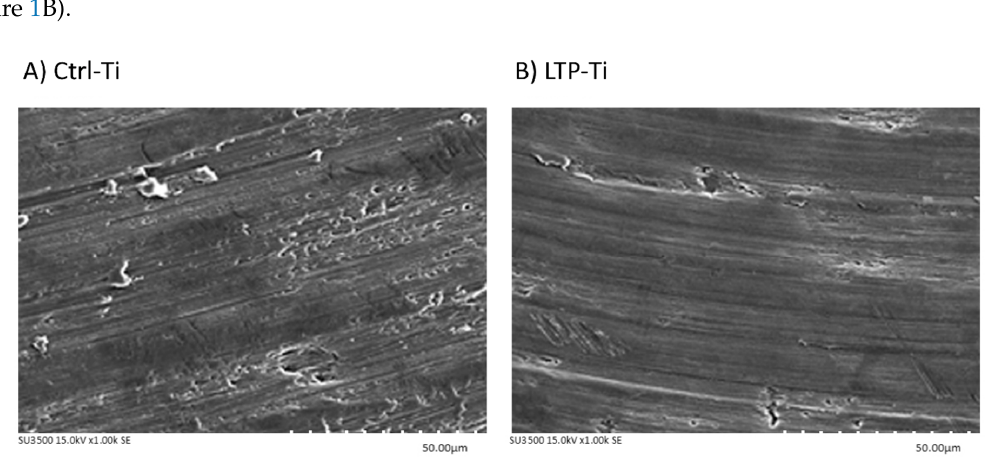
Figure 1. Implant surface images obtained with scanning electron microscopy (SEM). ( A ) Surface of the titanium disk treated with only autoclaving (Ctrl-Ti group). ( B ) Surface of the titanium disk treated with low-temperature plasma (LTP) after autoclaving (LTP-Ti